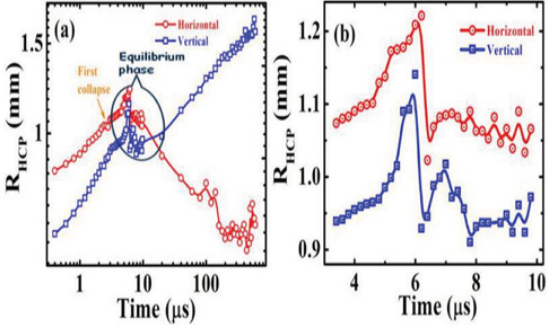
Figure 4. (a) Evolution of radius of the HCP (R HCP ) over the entire time delays observed and (b) Expanded view of the evolution RHCP during equilibrium phase (oscillation phase) immediately after detachment of SF from HCP oscillating analogous to that of an elliptic CB. Lines are guide to the